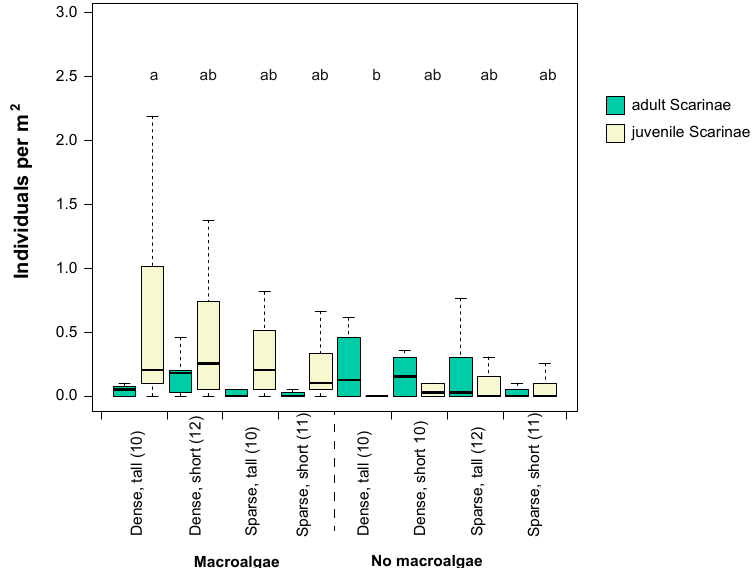
scraper/excavator x-axis compared to the other functional groups. scraper / excavator x-axis compared to the other functional groups.